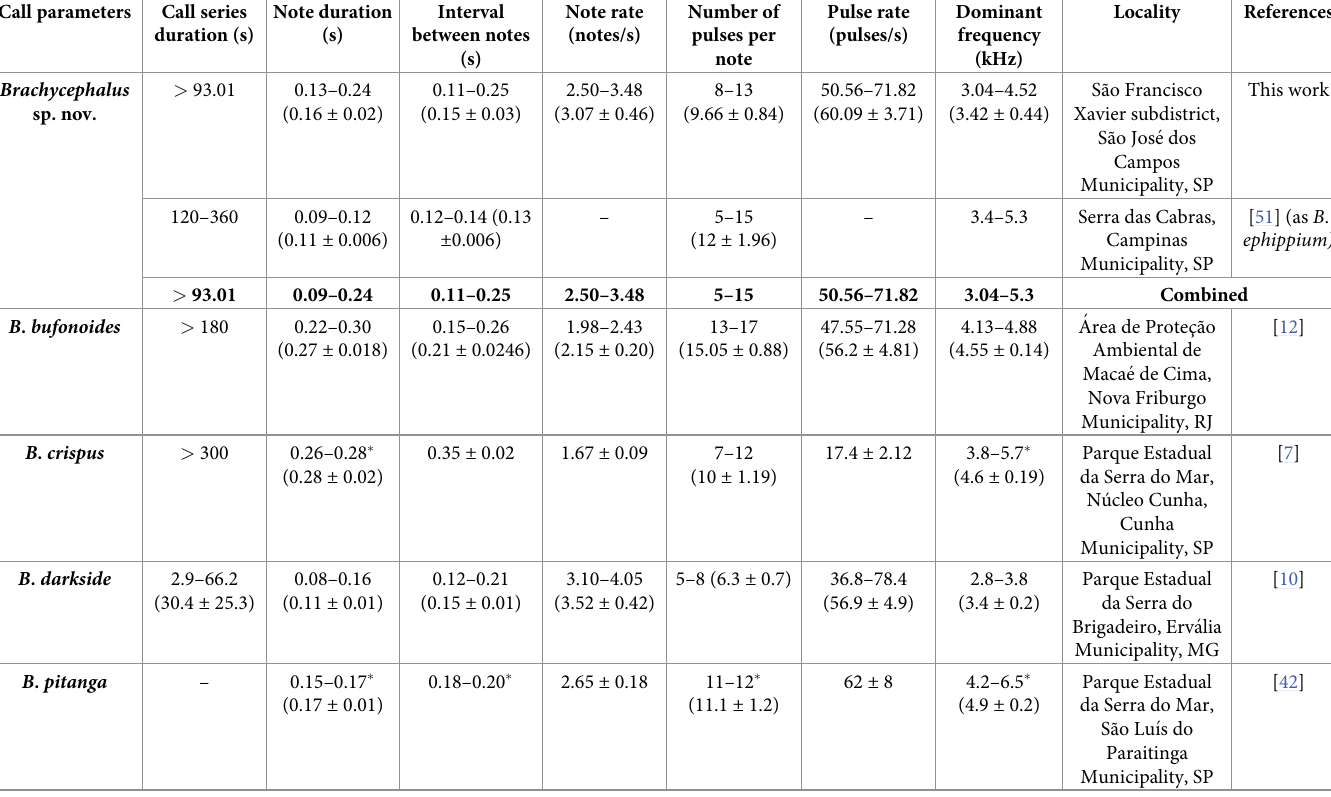
Table 1. Described advertisement calls of species belonging to the Brachycephalus ephippium